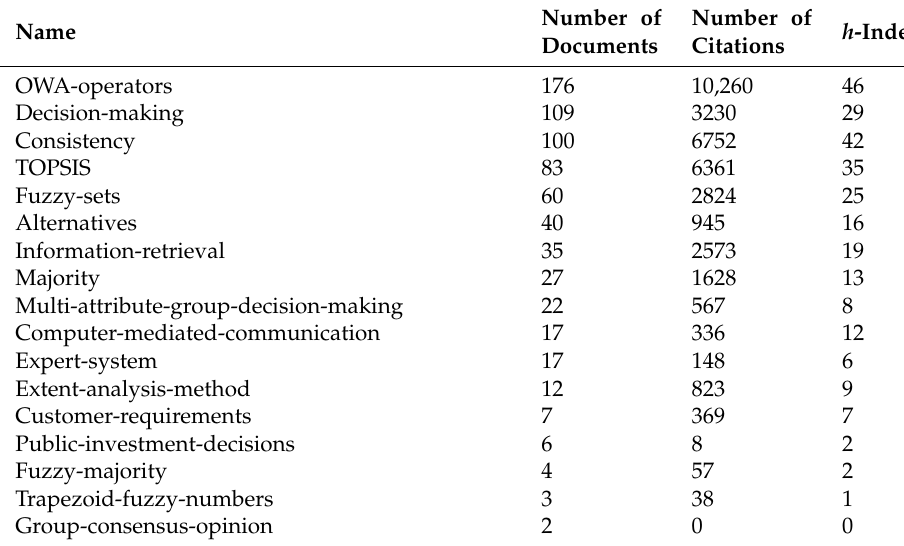
Table 4. Performance of the themes in the 1991–2009